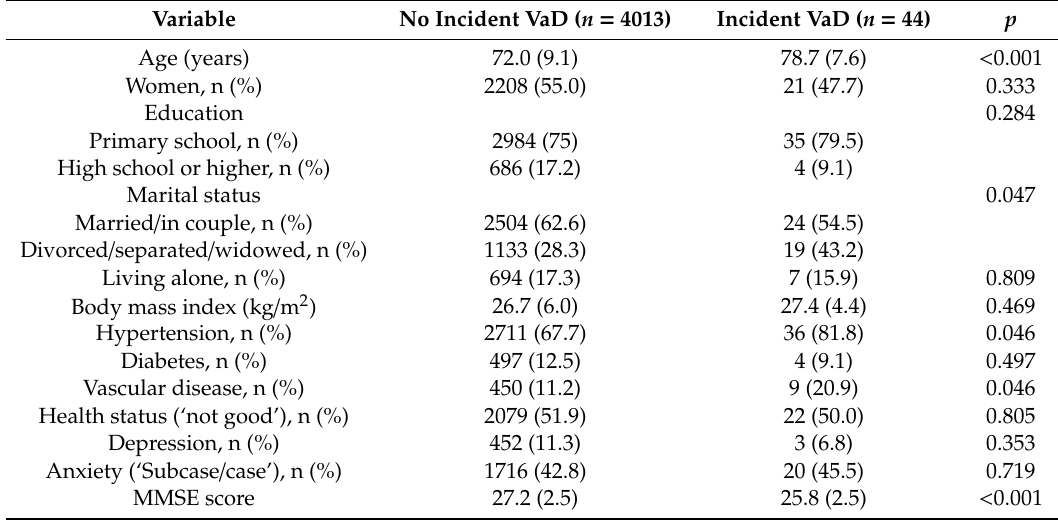
Table 1. Sociodemographic characteristics, medical risk factors, health status, depression, and cognitive status of the participants in the Zaragoza Dementia and Depression (ZARADEMP) study.